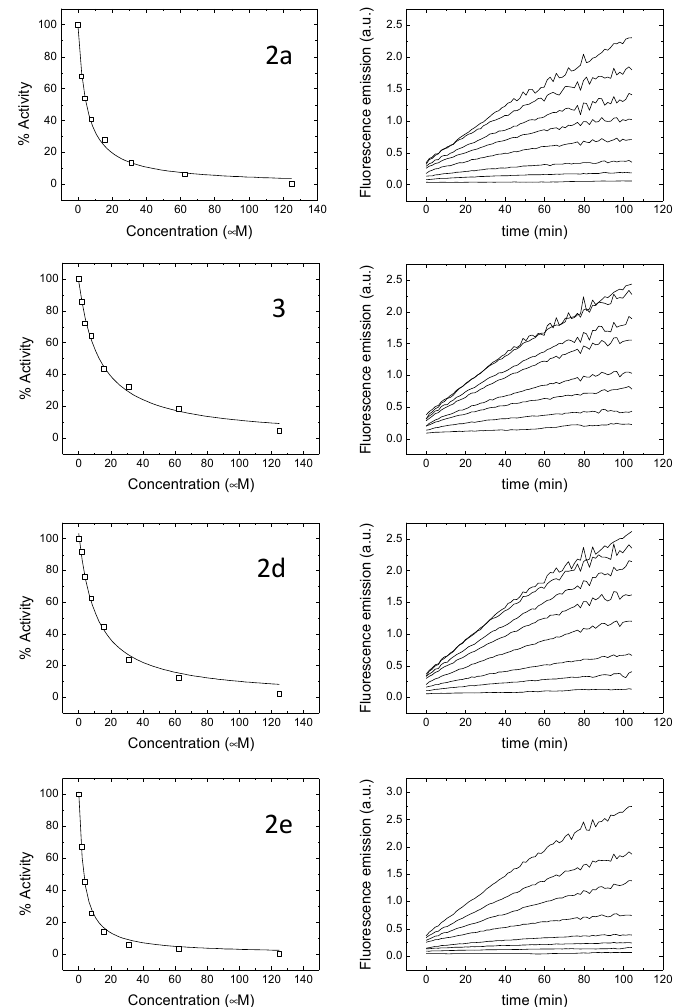
Figure 4. Inhibition curves ( left ) and time-course monitoring of M pro activity at increasing concentrations of compounds ( right ). Increasing the concentration of compounds results in diminished M pro activity. Nonlinear least-square regression data analysis was employed to determine the inhibition constant (K i ) and the half-maximal inhibitory concentration (IC 50 ). Table 3. K i and IC 50 values of the tested compounds. a